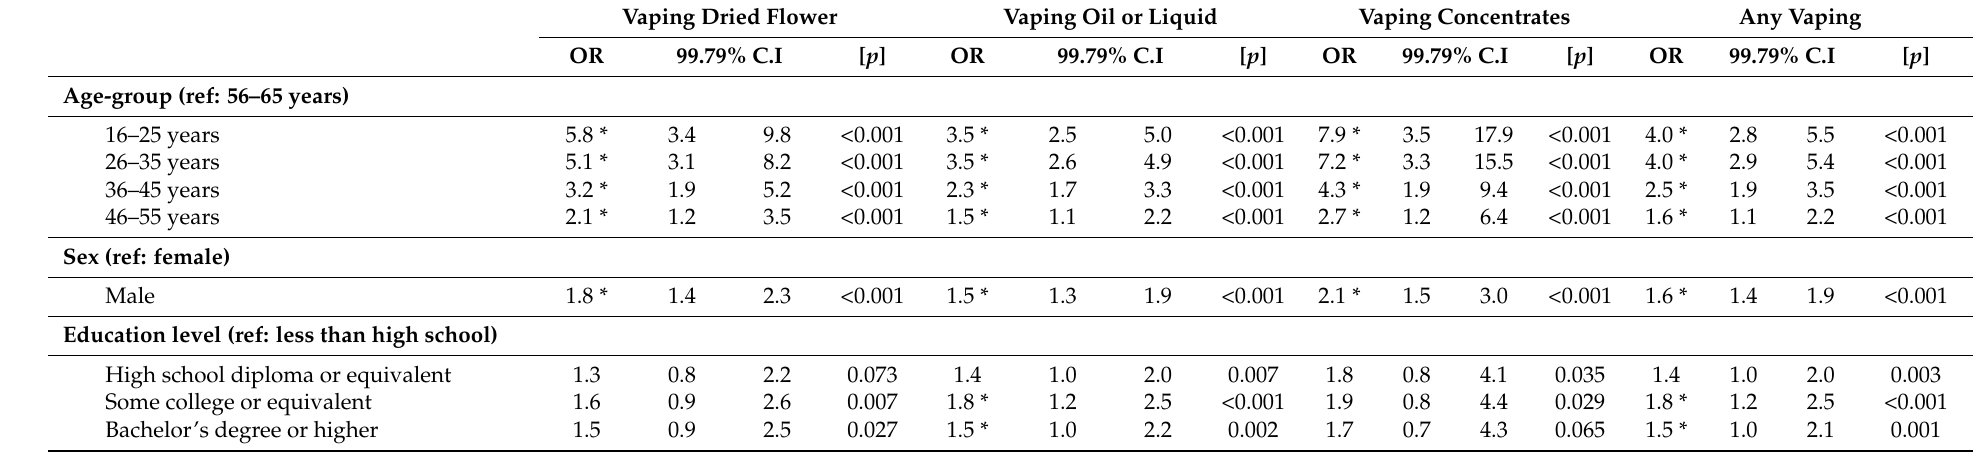
Table A3. Socio-demographics correlates and risk perception of vaping dried flower, oil or liquid, and concentrates in the past year (U.S. illegal jurisdictions) a